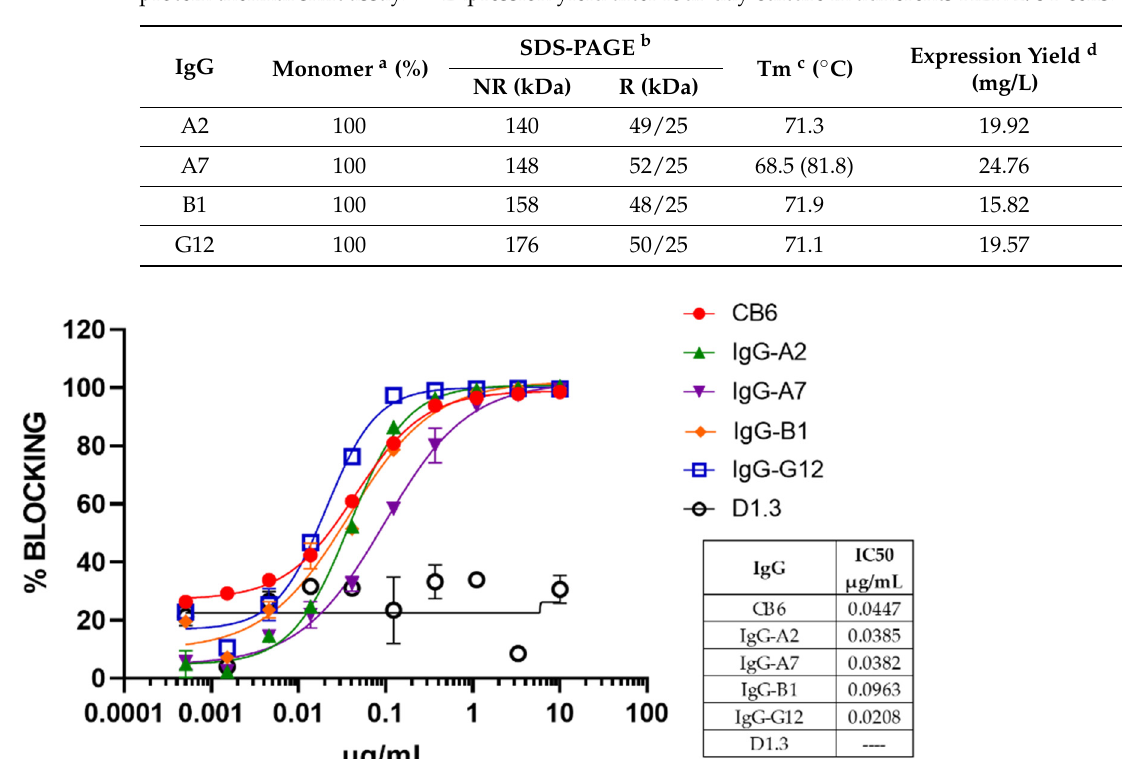
Table 2. Developability profile of the Protein-A purified anti-SARS-CoV-2 antibodies. (a) The percent of monomer as determined by analytical SEC. (b) SDS-PAGE. Molecular weight as estimated in non-reducing (NR) and reducing (R) conditions. In the latter, the first number corresponds with the heavy chain and the second with the light chain. (c) Melting temperature (Tm) as determined by protein thermal shift assay. (d) Expression yield after four-day culture in adherents HEK 293T cells.